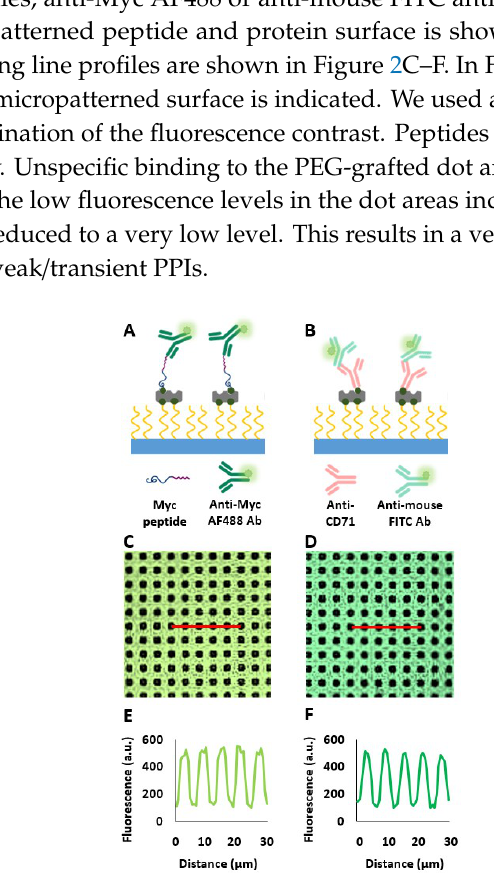
Figure 2. Determination of pattern contrast and biomolecule density on micropatterned substrates using fluorescence microscopy. ( A ) Schematic overview of micropatterned Myc peptide using anti-Myc AF488 Ab for detection. ( C ) Fluorescence image (image size: 65 × 65 µ m) and ( E ) the corresponding line profile. ( B ) Schematic overview of micropatterned anti-CD71 using anti-mouse FITC Ab for detection. ( D ) Fluorescence image (image size: 65 × 65 µ m) and ( F ) the corresponding line